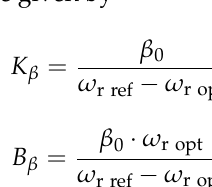
Figure 7. Schematic of DPAC: ( a ) turning the pitch angle depending on rotor speed; ( b ) mechanical power with the DPAC scheme.